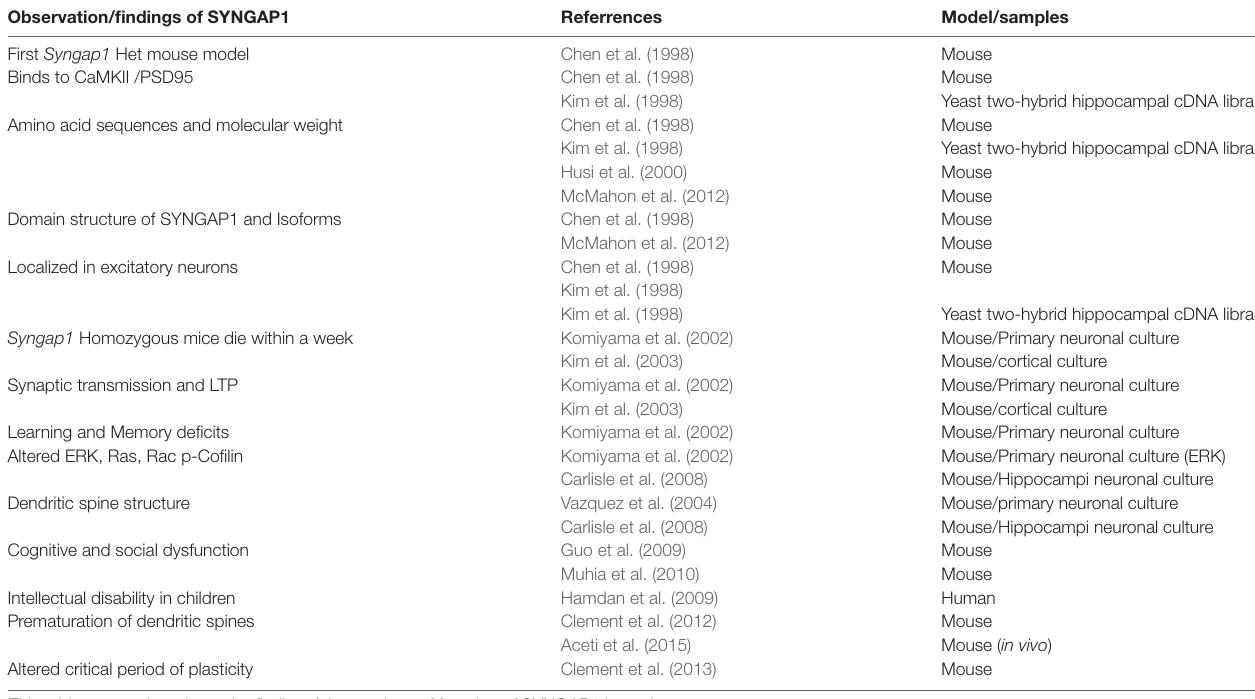
TABLE 1 | Historical perspective of major findings of SYNGAP1